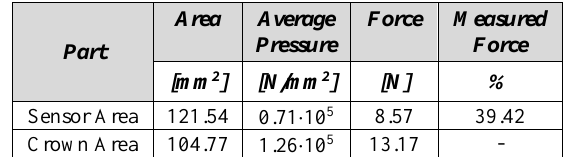
Table 5. Percentage of forces which is applied to the sensor when using the Deep5R8 sensor